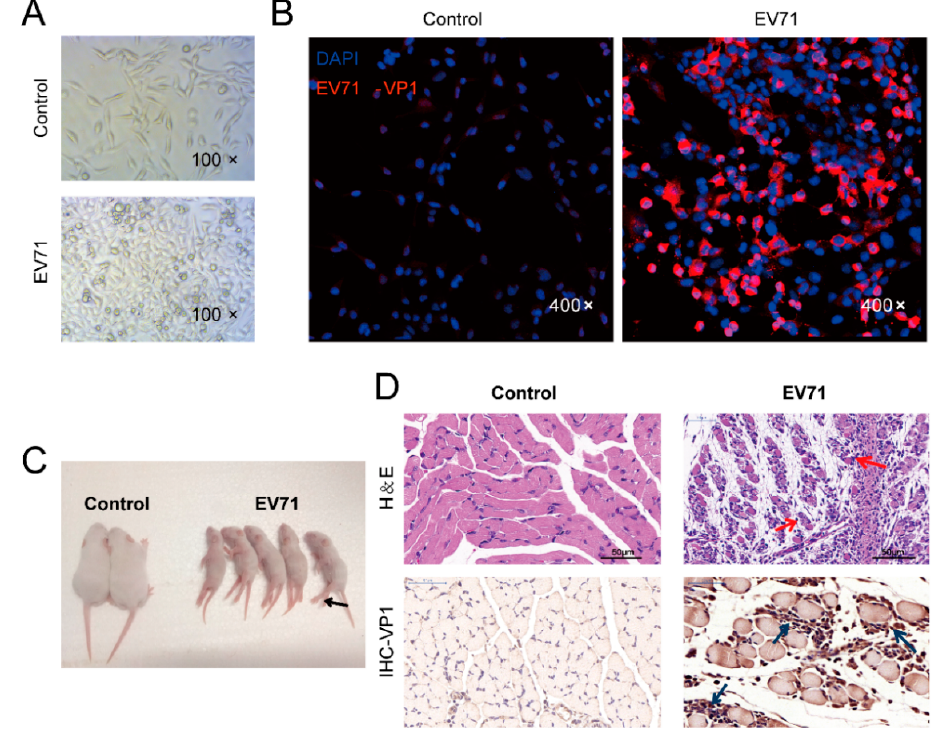
Figure 2. In vitro and in vivo models of EV71 infection. ( A ) Cytopathic effects in RD cells were captured via light microscopy (amplification: 100 × ) at 24 h post infection. ( B ) EV71 VP1 distribution in RD cells was imaged via confocal microscopy (amplification: 400 × ) at 24 hpi. ( C ) Clinical presentation in neonatal mice following EV71 infection. ( D ) Histopathological examination and EV71 VP1